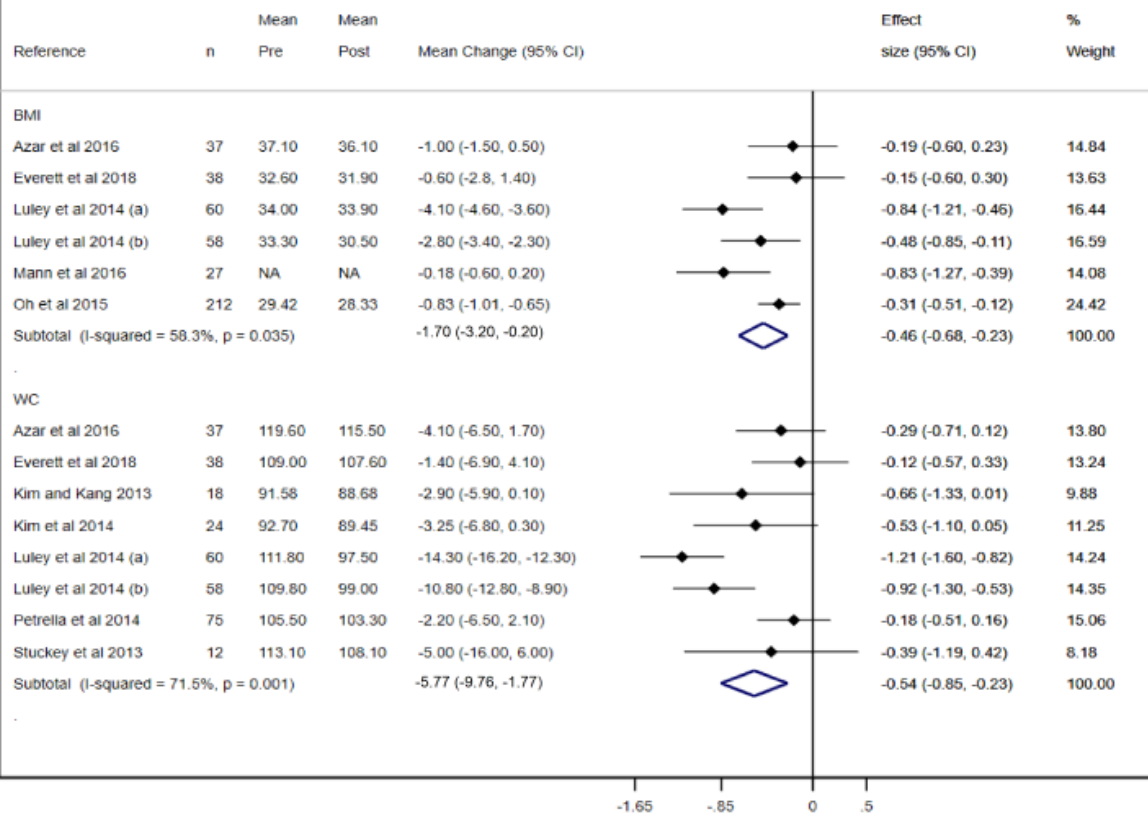
−0.11; effect size: −0.44) for DBP, with substantial heterogeneity for SBP ( I 2 =75%) and DBP ( I 2 =69%) (Figure